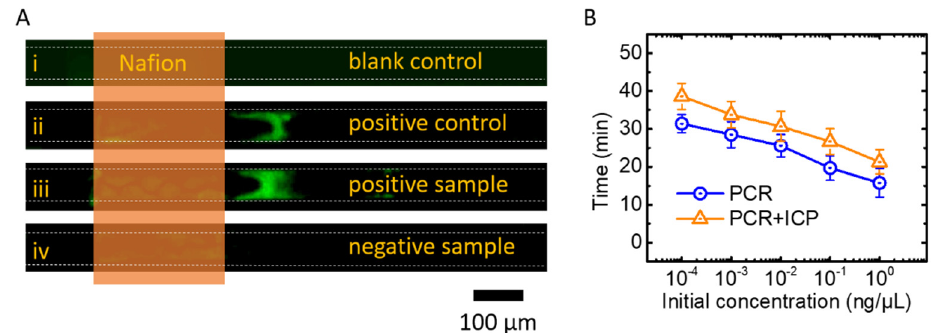
Figure 4. Application of meat products authenticating. ( A ) Results of nucleic acid preconcentration in the experimental and control groups. ( B ) Time as a function of original concentration during nucleic acid amplifications.